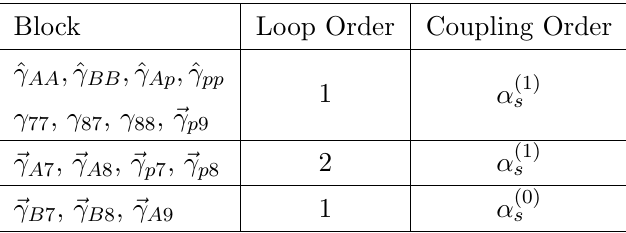
and Q imply that the form (2.11) is maintained. On the other 7 (cid:13) 8 g , ~(cid:13) , ~(cid:13) and ~(cid:13) are non-zero at one loop, but with no c 7 c 8 c 9 p 9 s